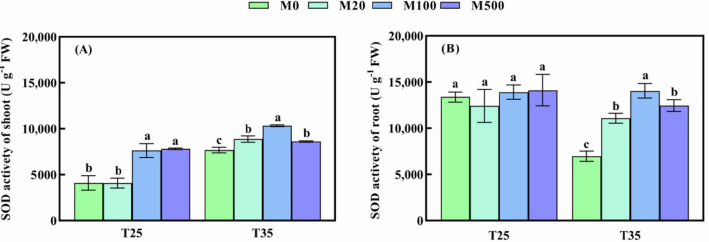
Figure 2. Effects of exogenous melatonin on SOD activity in the rice seed shoots and roots under drought stress. Means ± SEs with different letters in each parameter indicate significant statistical differences (LSD, 0.05). ( A ) SOD activity of shoot; ( B ) SOD activity of